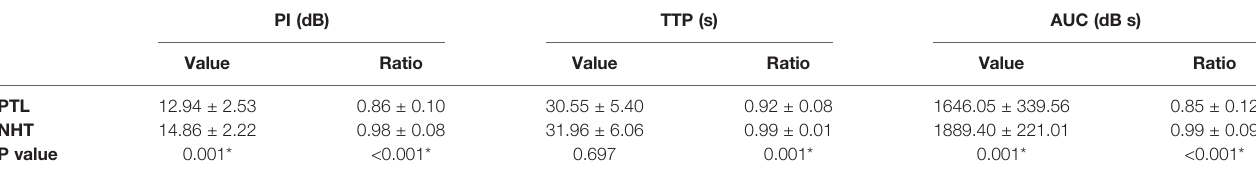
TABLE 3 | CEUS quanti fi cation parameters of PTL and NHT coexistent with Hashimoto ’ s